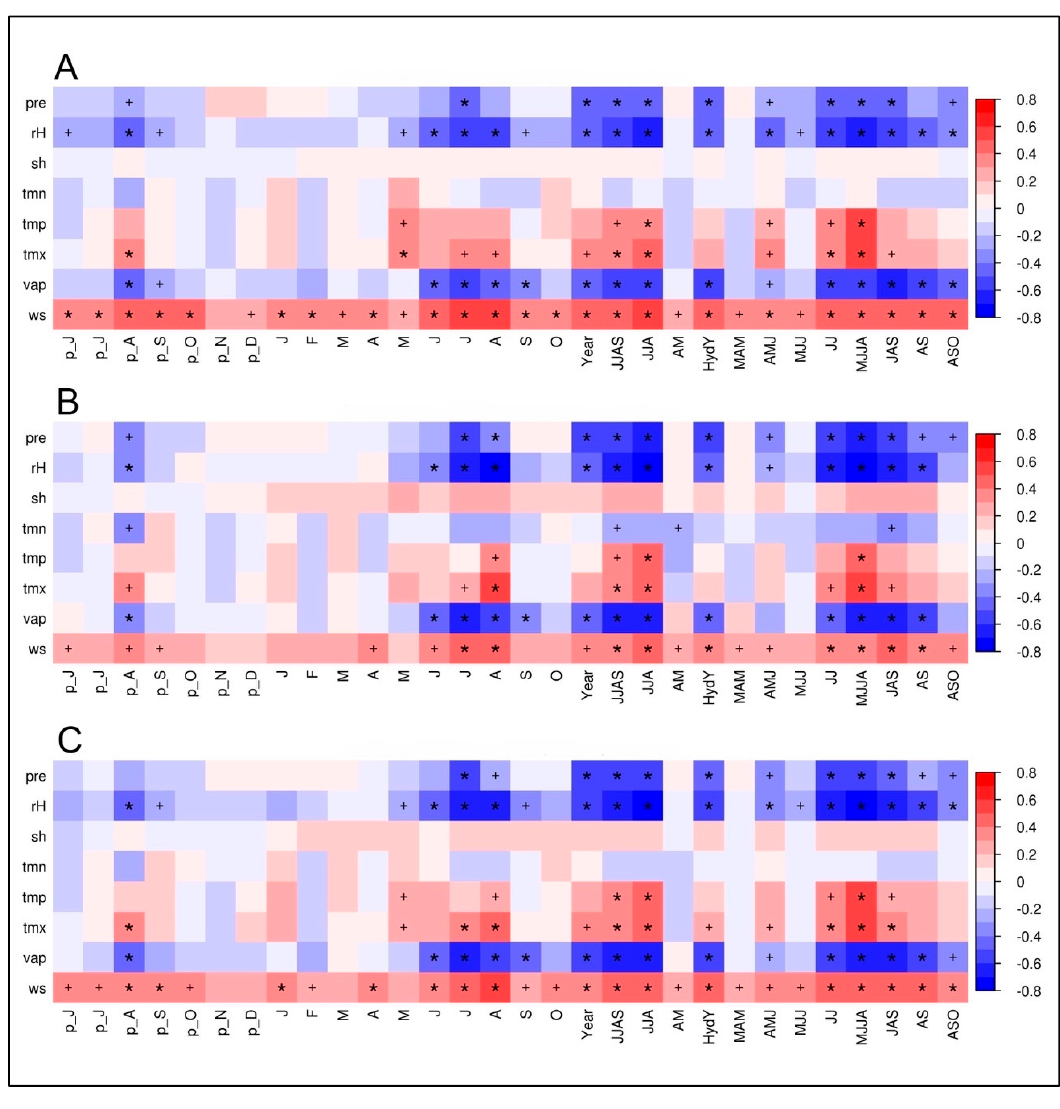
Figure 5. Climate–proxy relationships between δ 18 O TRC of: juniper trees ( A ); spruce trees ( B ); and the site-internal δ 18 O TRC mean ( C ) plotted against monthly and seasonal averages of different climate parameters (pre, precipitation; rH, relative humidity; sh, sunshine hours; tmn, minimum temperature; tmp, mean temperature; tmx, maximum temperature; vap, vapor pressure deficit; ws, wind speed) from Qamdo climate station for the period 1954–2007 (n = 54). The prefix “p” indicates relationships to the previous years’ monthly means. Red/blue colors indicate positive/negative correlation coefficients (r). The respective level of significance is displayed by a plus sign (p < 0.05) or an asterisk (p <